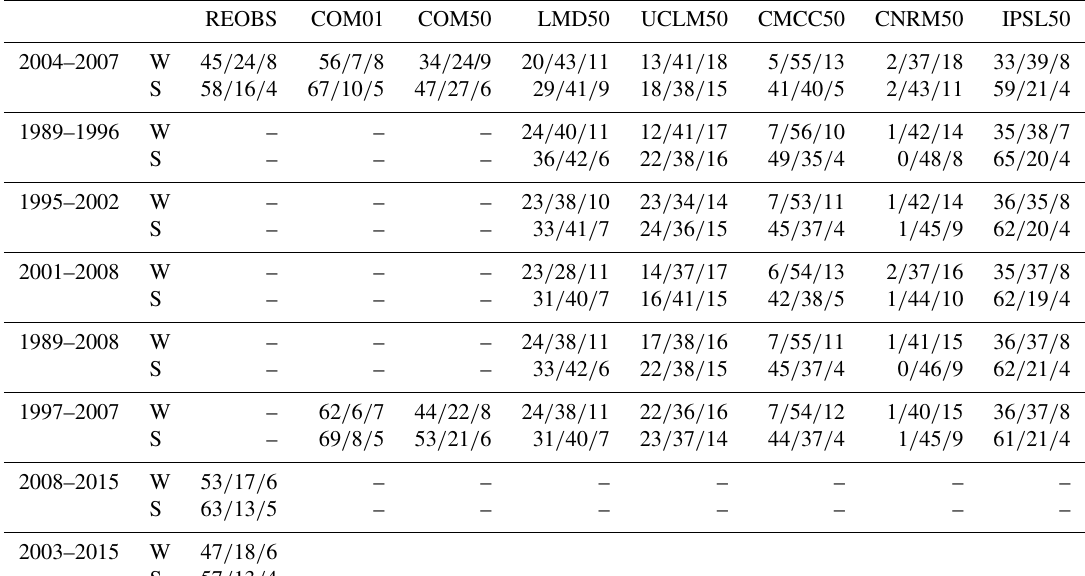
Table 4. Occurrence (%) of nonprecipitating days (first number), very light precipitation (second number) and light precipitation (third number) for different datasets (columns) computed over different years (rows) for two different periods of the year: W is for winter (Julian day from 1 to 100) and S is for summer (Julian day from 151 to 251). Native grids are